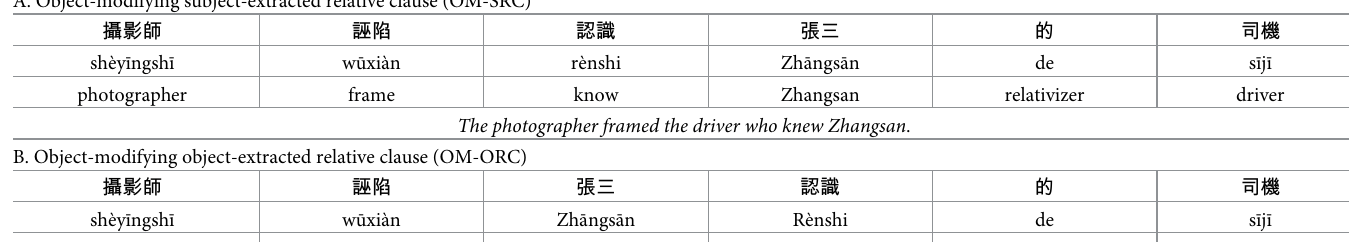
Table 1. The examples of OM-SRC, OM-ORC, SM-SRC, and SM-ORC sentences. A. Object-modifying subject-extracted relative clause